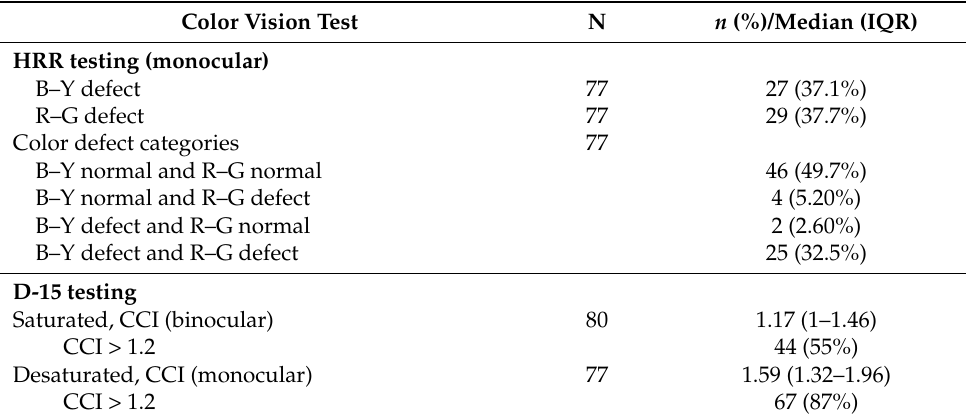
Table 4. Distribution of color vision testing results.